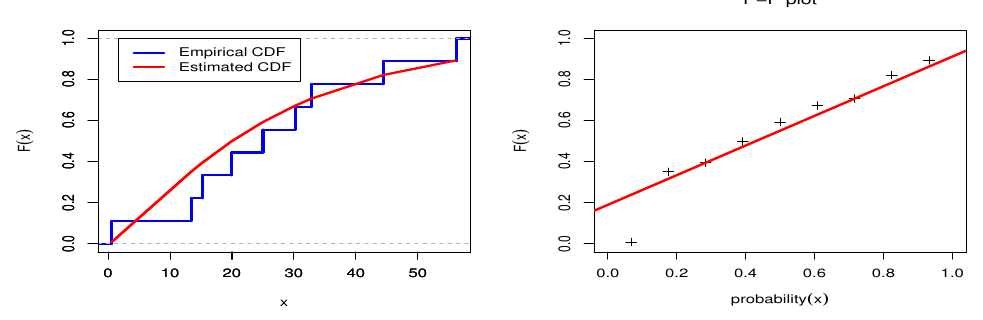
Figure 4. Empirical CDF and P-P plots for the EED for dataset 1.